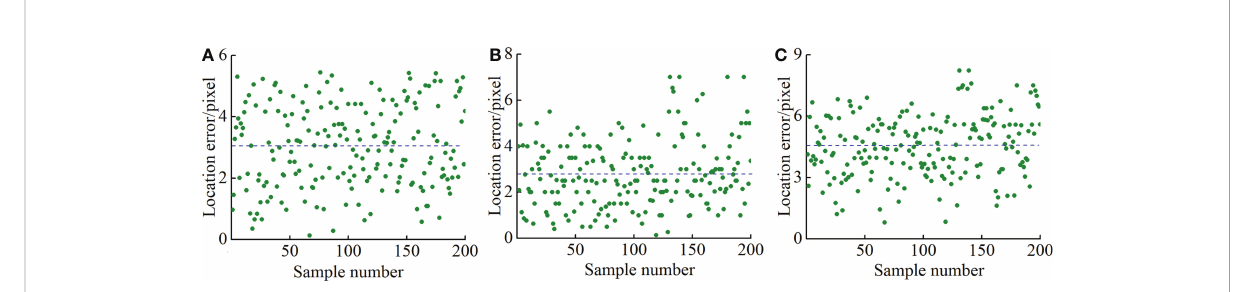
FIGURE 11 Location error of new tapping line. (A) Location error in x , (B) location error in y , and (C) total location